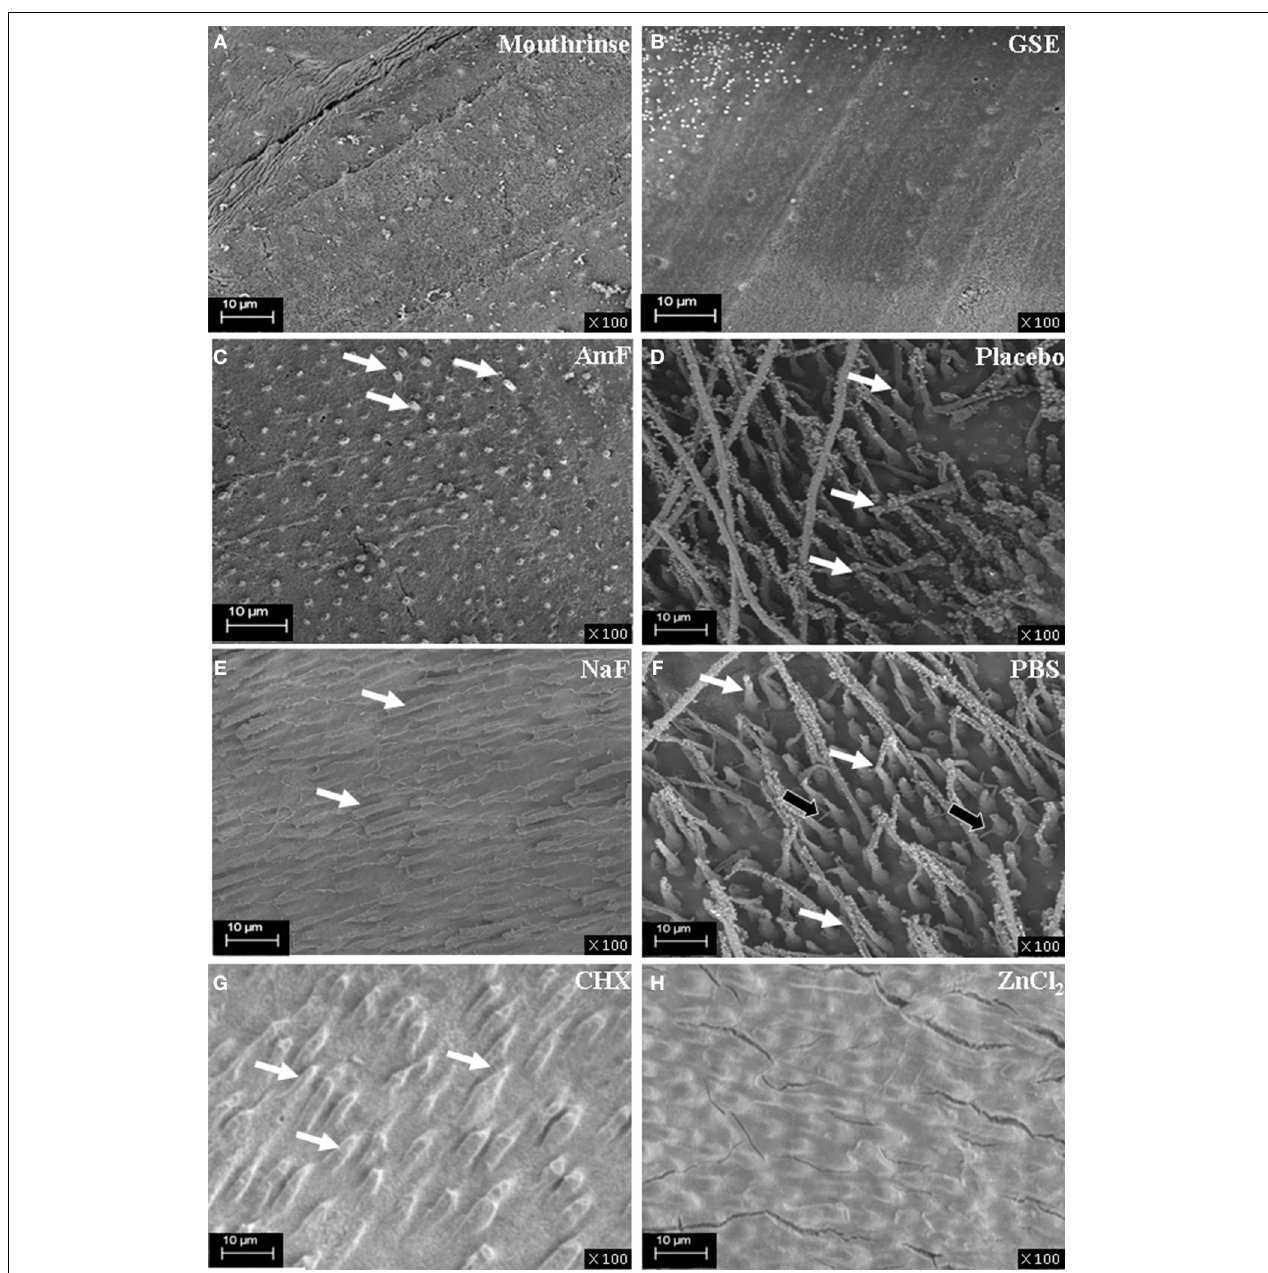
FIGURE 3 | SEM analysis of resin replicas of the demineralized, pre-treated and MMP-3 treated dentin blocks. The resin penetration is absent in the mouthrinse groups (A) and GSE (B) as no tubule is enlarged by the MMP-3 treatment and penetrated by resin; a regular dentin surface is observed. In the AmF group (C) , sparse penetrations of resin are seen (white arrows). In the NaF group (E) , mildly infiltrated dentinal tubules are visualized (white arrows). In contrast, a very deep